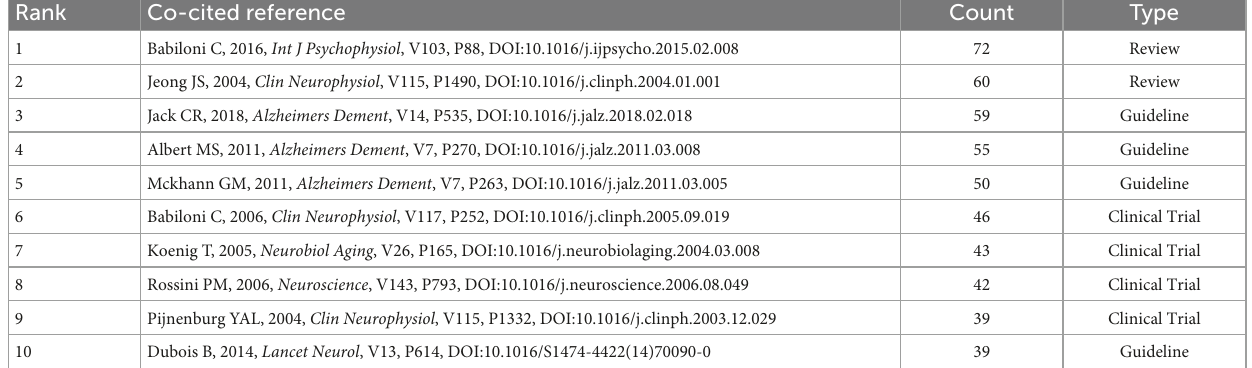
TABLE 6 Top 10 co-cited references involved in research on EEG for